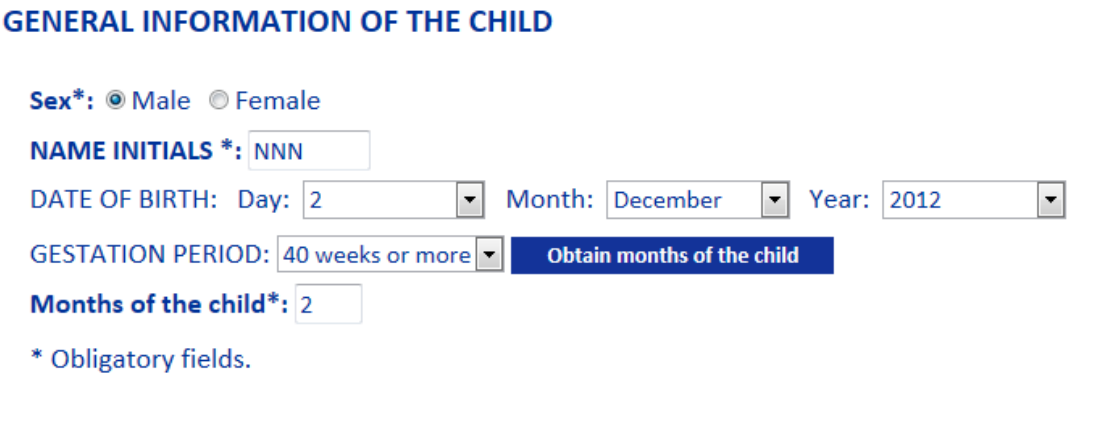
Figure 11. Gades process of language evaluation. General information of the child for starting the process of language